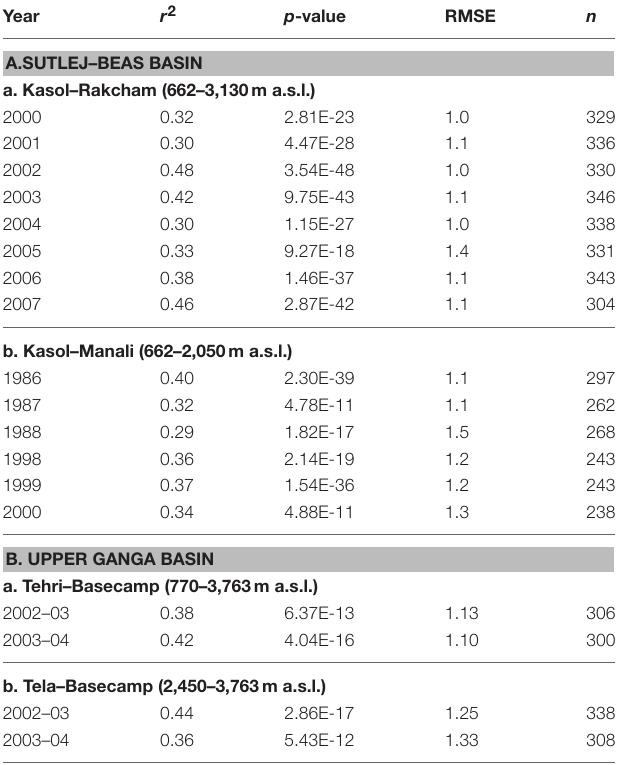
TABLE 6 | Results of the model test for daily SELR for (A) Sutlej–Beas basin data (2000–2007) (B) For upper Ganga